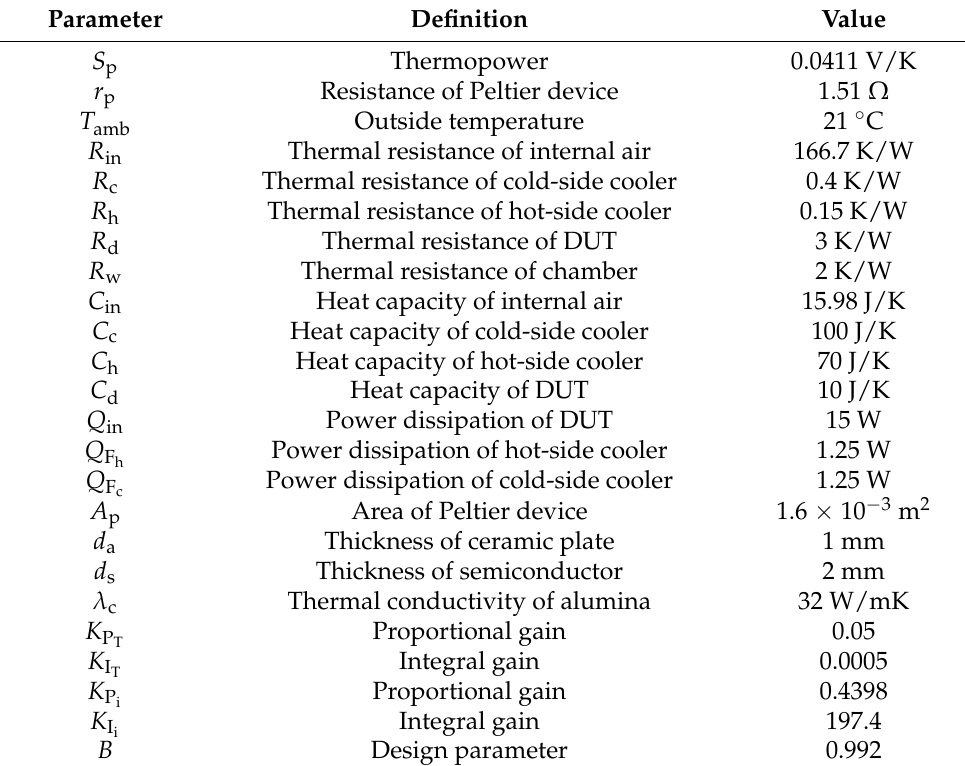
Table 3. Simulation